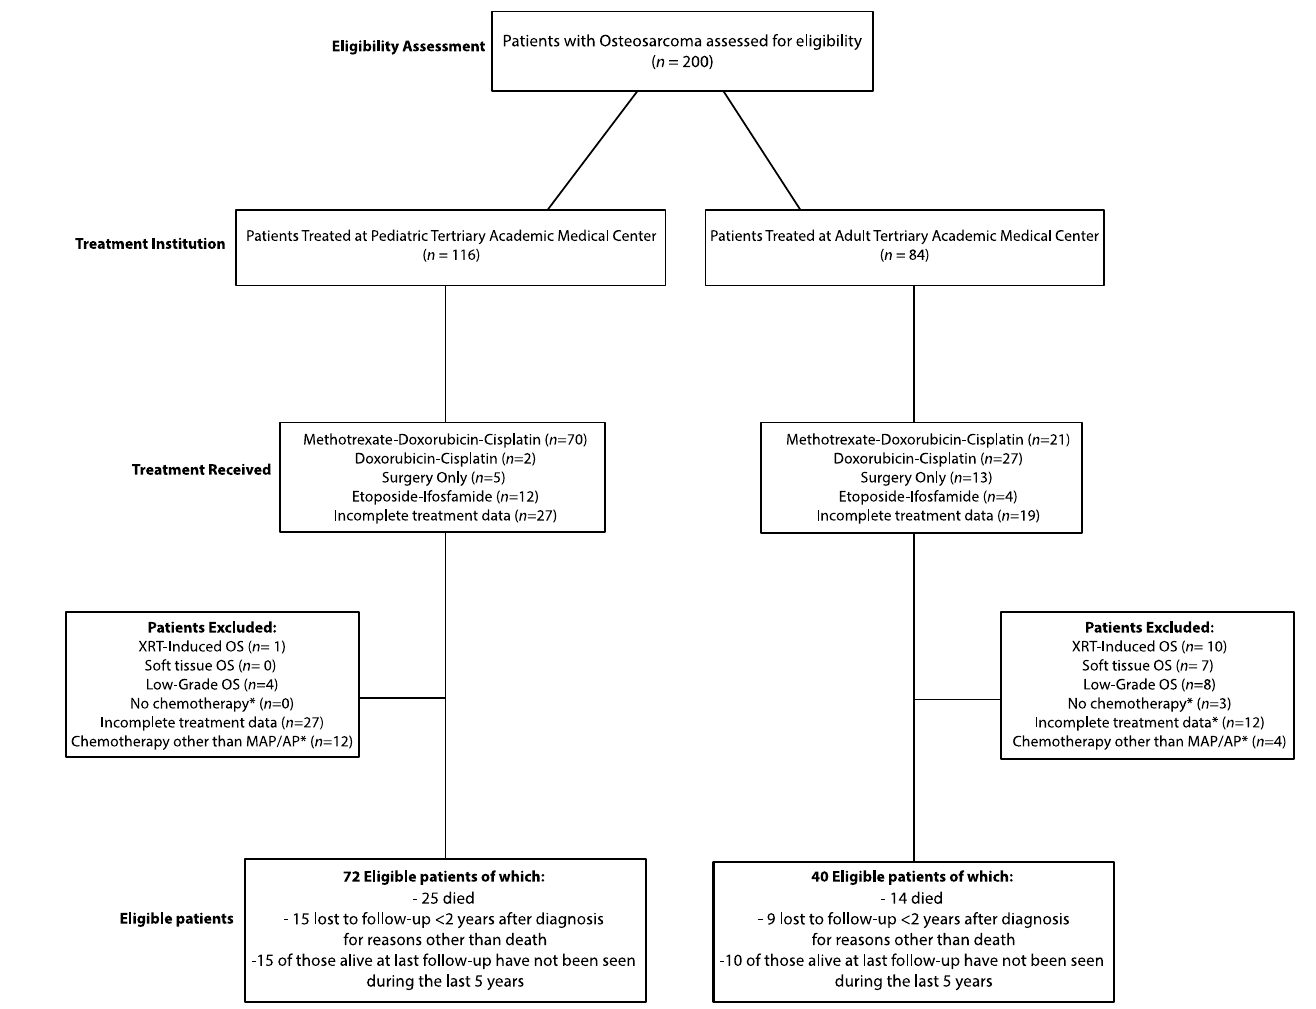
Figure 1. Patient Selection. (*) If not excluded for other criteria.